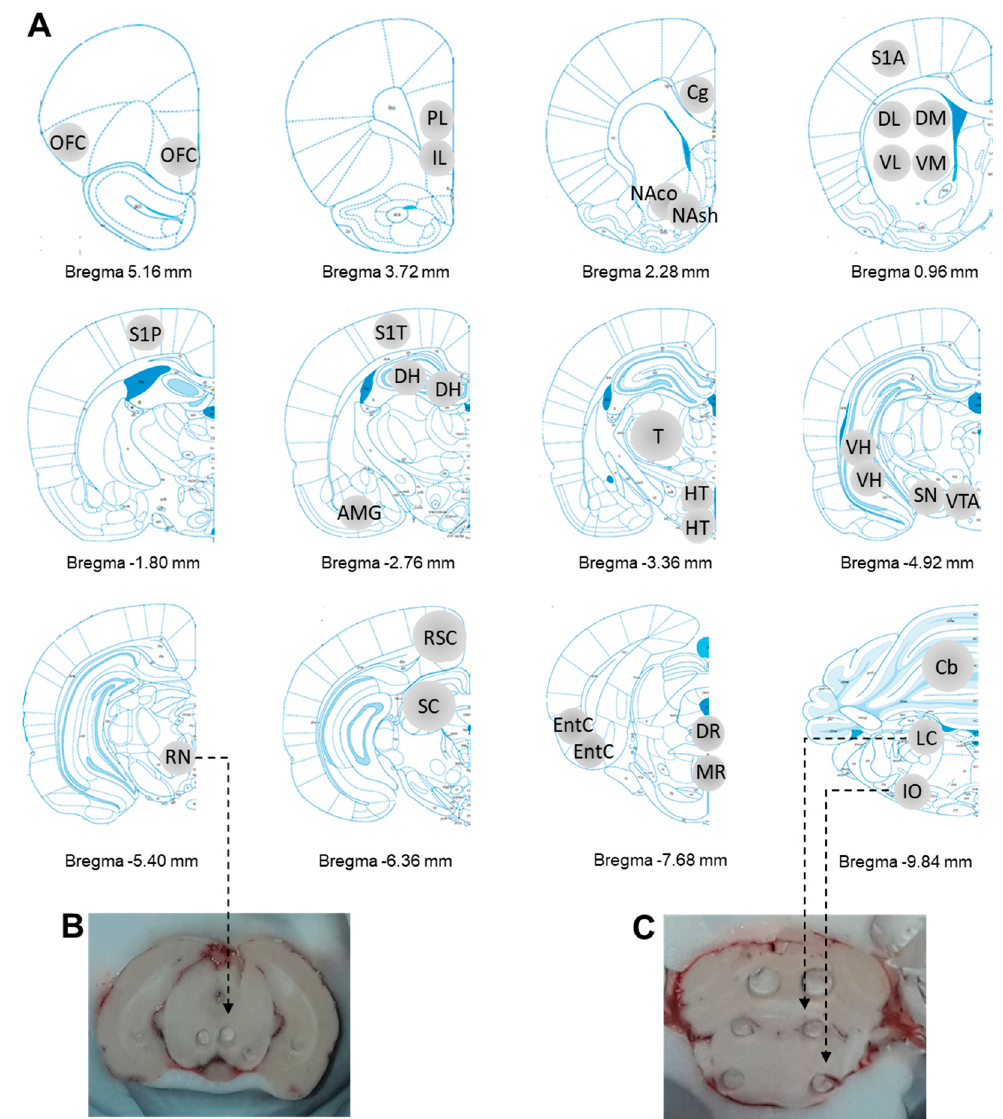
Figure 2. ( A ). Brain regions sampled from Bregma +5.16 to − 9.84 mm. OFC = Orbitofrontal cortex, PL = Prelimbic cortex, IL = Infralimbic cortex, Cg = Cingular cortex, NAco = Nucleus accumbens core, Nash = Nucleus accumbens shell, DM = Dorsomedial striatum, DL = Dorsolateral striatum, VL = Ventrolateral striatum, VM = ventromedial striatum, S1A = Primary somatosensory anterior cortex, S1P = Primary somatosensory posterior cortex, S1T = Primary somatosensory trunk cortex, DH = Dorsal hippocampus, AMG = Amygdala, T = Thalamus, HT = Hypothalamus, VH = Ventral hippocampus, SN = Substantia nigra, VTA = Ventral tegmental area, RN = Red nucleus, RSC = Retrosplenial cortex, SC = Superior colliculus, EntC = Entorhinal cortex, DR = Dorsal raphe, MR = Median raphe, Cb = Cerebellum, LC = Locus coeruleus and IO = Inferior olive. OB = Olfactory bulb (not illustrated). ( B ). Example of RN collection in brain. ( C ). Example of LC and IO collection in brain.